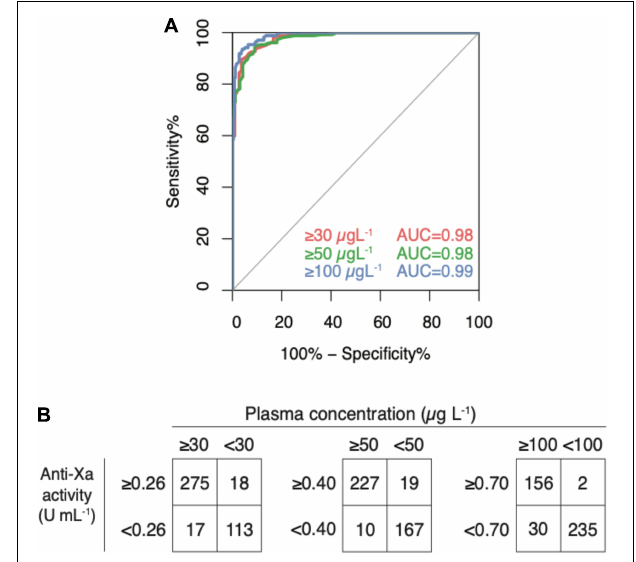
FIGURE 4 | Diagnostic accuracy of a universal, heparin-calibrated anti-Xa assay for the measurement of rivaroxaban, apixaban, and edoxaban drug concentrations in clinical practice (derivation dataset; n = 422). (A) Receiver-operating characteristics curve (ROC) showing the diagnostic accuracy. The area under the ROC curve was 0.99 for all cut-offs. (B) Confusion matrices at each cut-off. Drug levels above 30 µ g L − 1 were detected with a sensitivity of 96.9% (95% CI 94.3, 98.5; cut-off value 0.26 U mL − 1 ), drug levels above 50 µ g L − 1 with a sensitivity of 95.2% (95% CI 92.0,